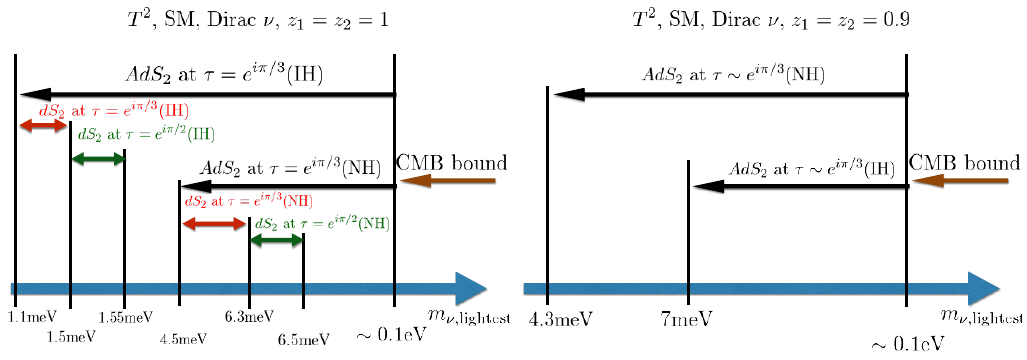
Figure 20 . Same as (cid:12)gure 13, but for the SM with Dirac neutrino. Regarding the boundary condition z 1 = z 2 = 0 : 9, we concentrate on the AdS 2 vacuum where the value of (cid:28) is around e i(cid:25)= 3 . The corresponding two-dimensional vacua is AdS (cid:2) T 2 . For example, if we take 2